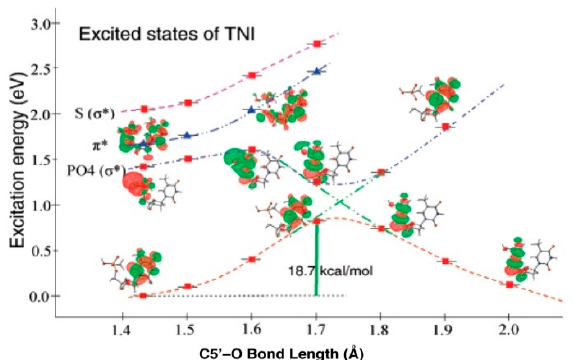
Figure 13. The lower curve shows the energy of the 5 ′ -dTMPH − * TNI as the C5 ′ -O bond is lengthened. Extension of the bond allows the TNI to move from the bound π ground state in which the SOMO is located largely on the thymine base to a dissociative σ (PO 4 )* state in which the SOMO on the phosphate group. Reprinted with permission from reference [103], copyright 2008 American Chemical Society.